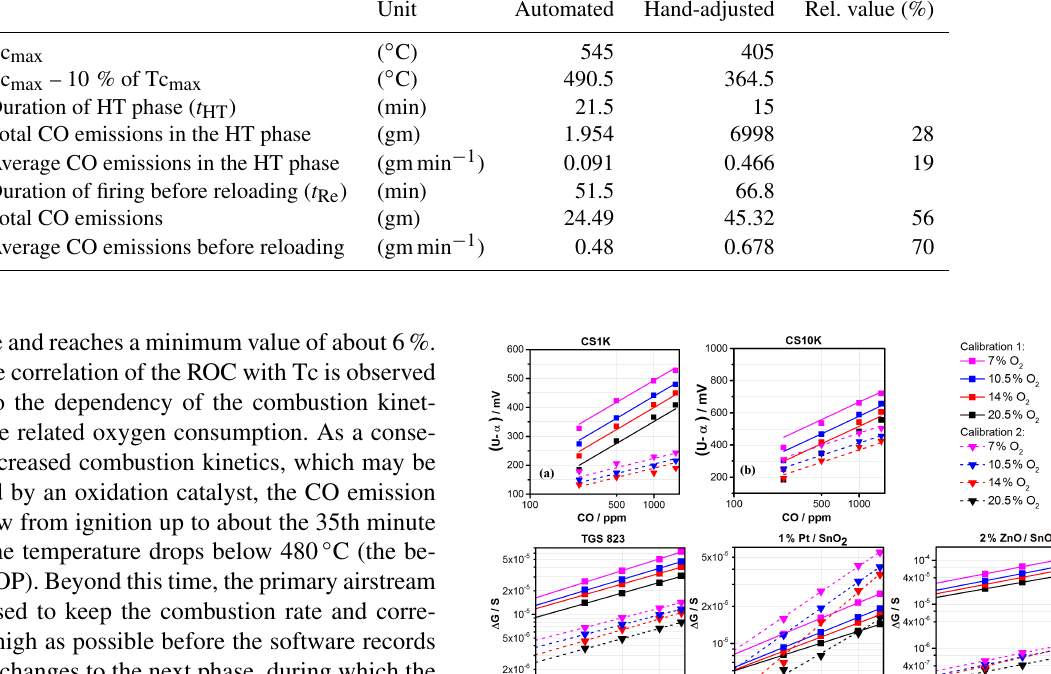
Table 1. A comparison of CO emissions between an automated and a hand-adjusted Varia R stove. Unit Automated Hand-adjusted